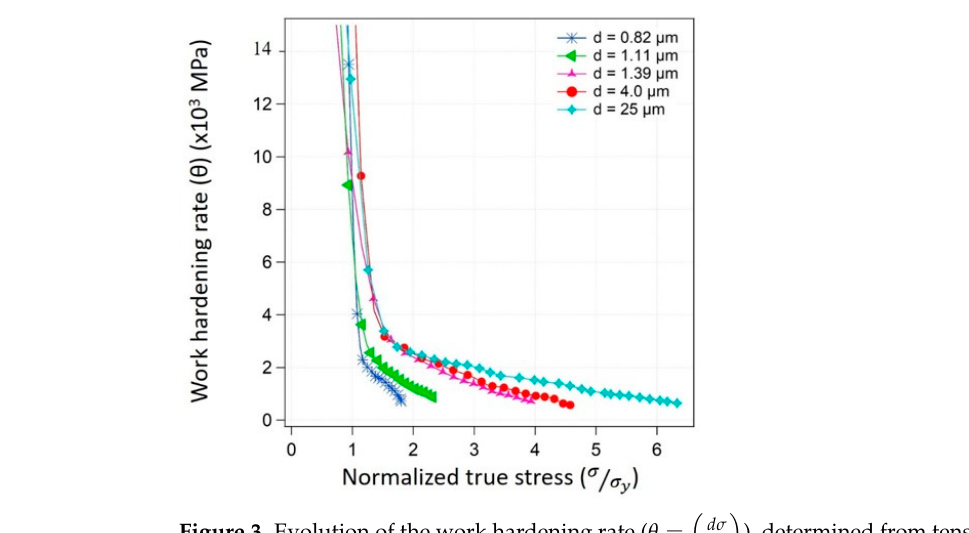
Figure 3. Evolution of the work hardening rate ( θ = (cid:4672) (cid:3031)(cid:3097) at a strain rate of 10 − 3 s − 1 , with true stress normalized by yield strength for Ni samples prepared by SPS with different grain sizes. The average grain size of the samples is indicated in a color scale for each figure.